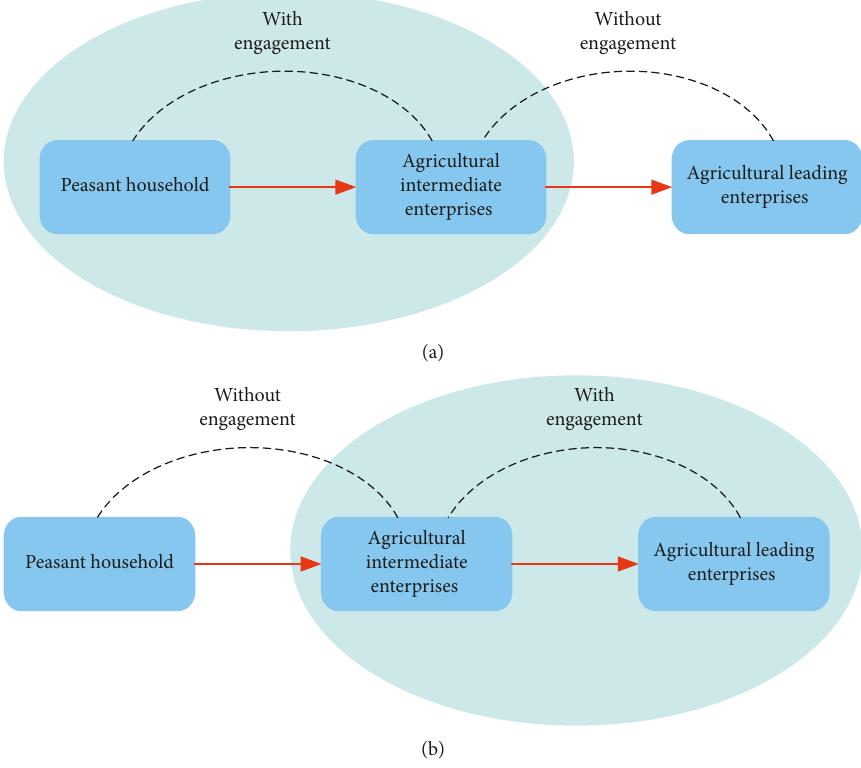
Figure 5: Schematic diagram of construction of local cooperative agricultural industry chain.